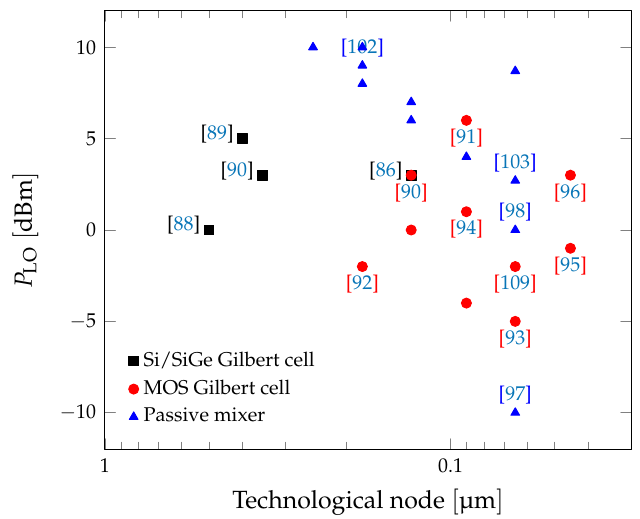
Figure 21. P LO plotted versus technological node for Gilbert and passive mixers.